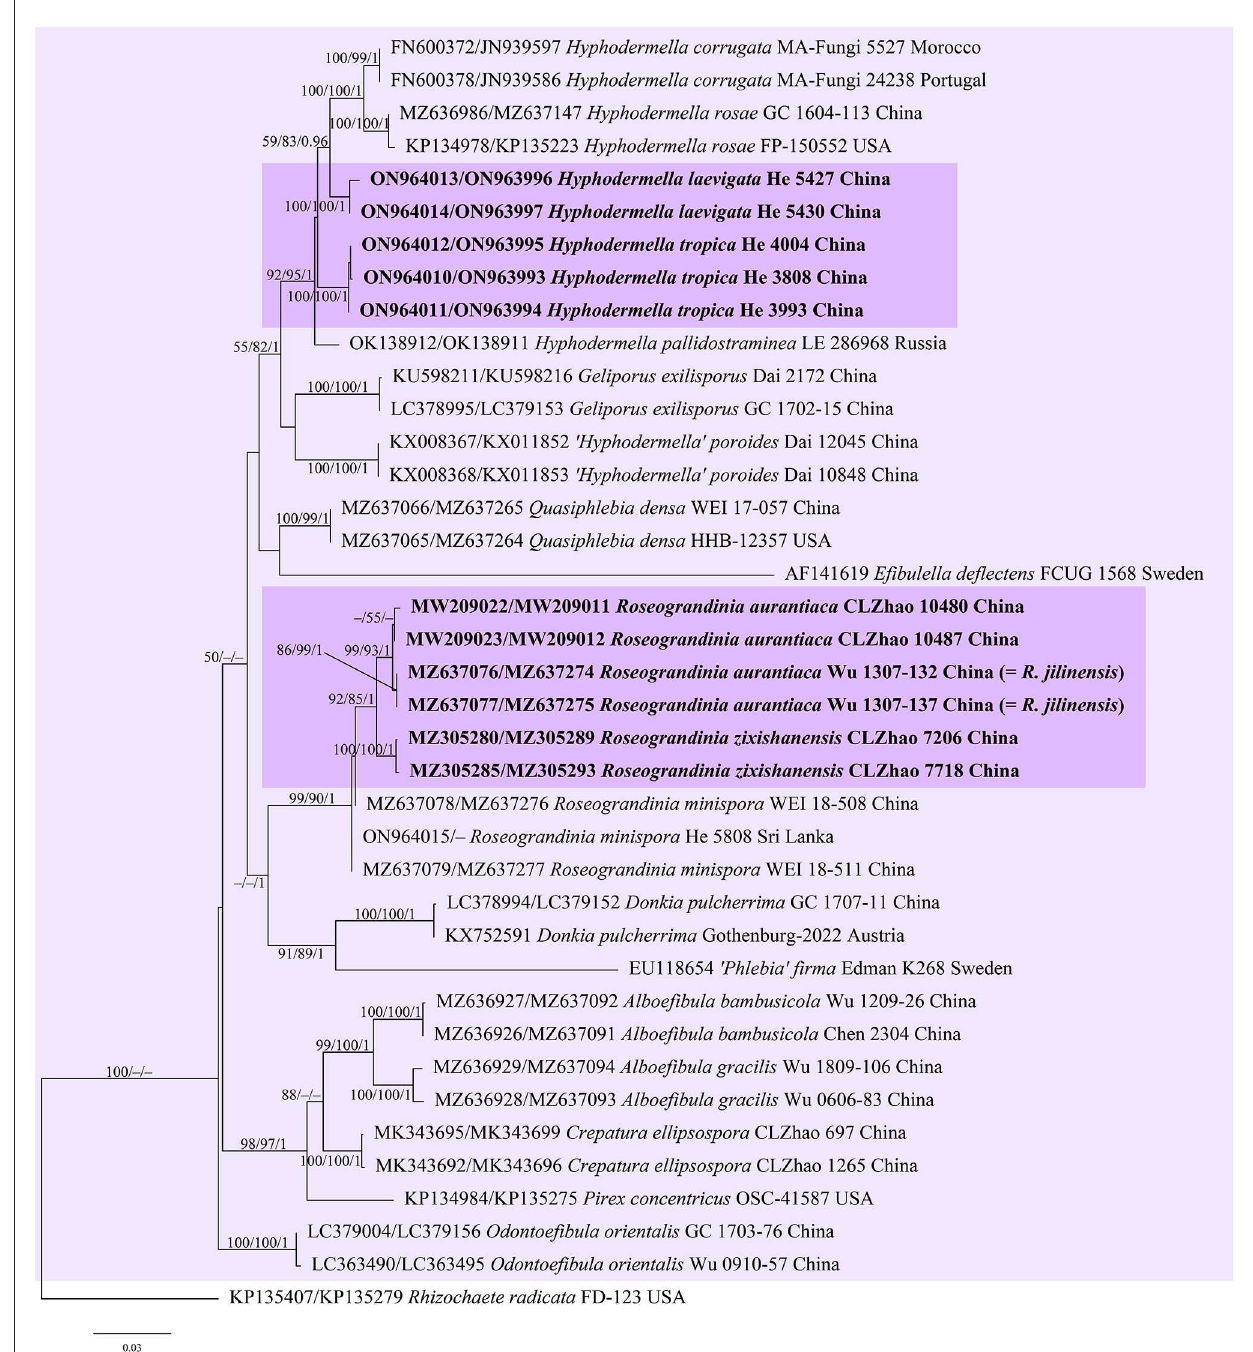
FIGURE1 Phylogenetic tree obtained from ML analysis of the ITS-nrLSU sequences of the Donkia clade. Branches are labeled with parsimony bootstrap values ( ≥ 50%, first), likelihood bootstrap values ( ≥ 50%, second), and Bayesian posterior probabilities ( ≥ 0.95, third). New taxa are set in bold and highlighted.